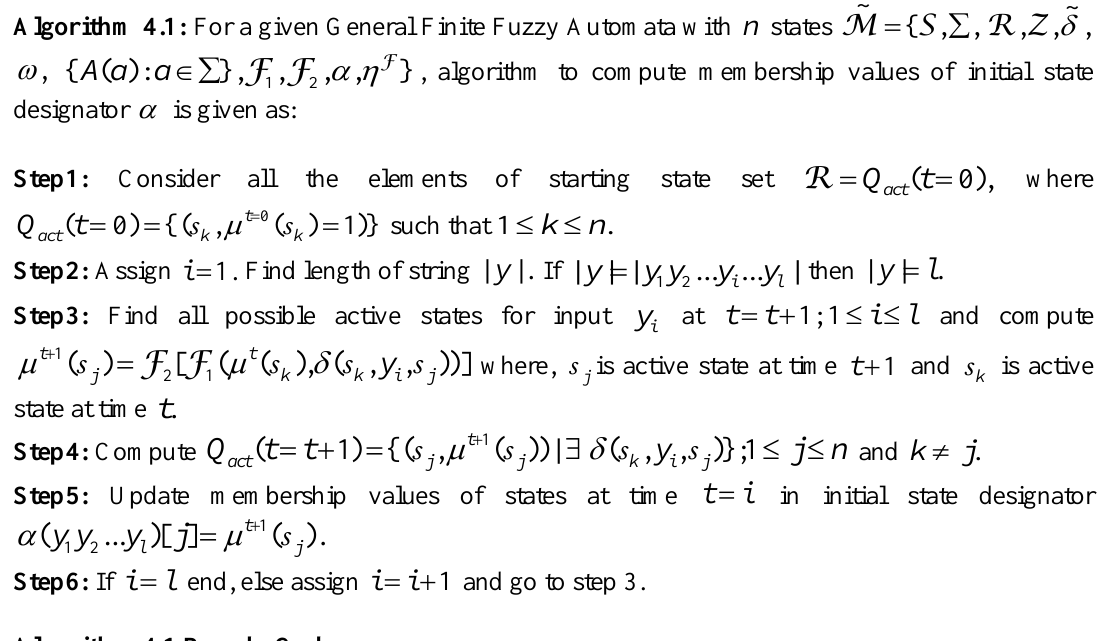
Algorithm 4.1: For a given General Finite Fuzzy Automata with n states